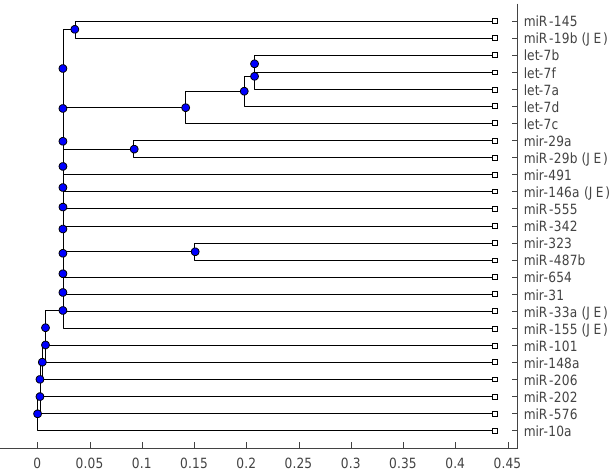
Figure 3. The phylogenetic tree of miRNAs based on the p-distance and median linkage function.